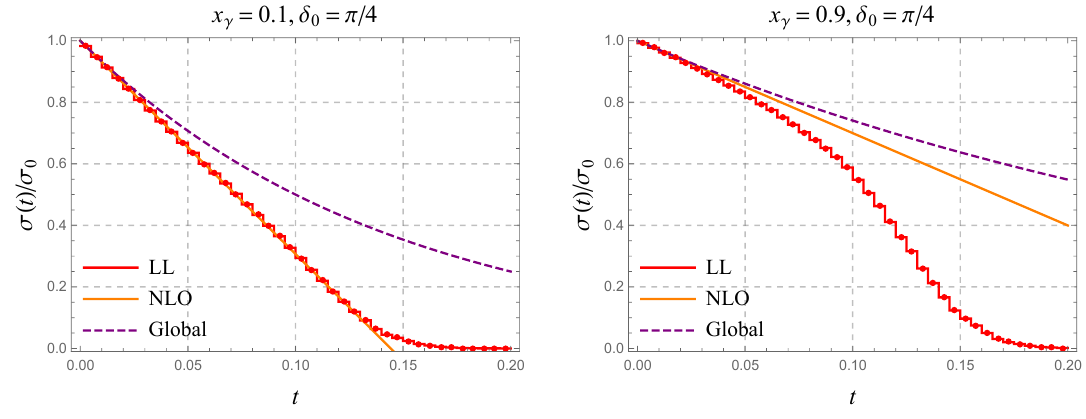
Figure 9 . E(cid:11)ect of the isolation cut in e + e (cid:0) ! (cid:13) + X . The plot shows a comparison of the resummed result (red line) with the one-loop contribution (orange line) and the global logarithms (dashed purple